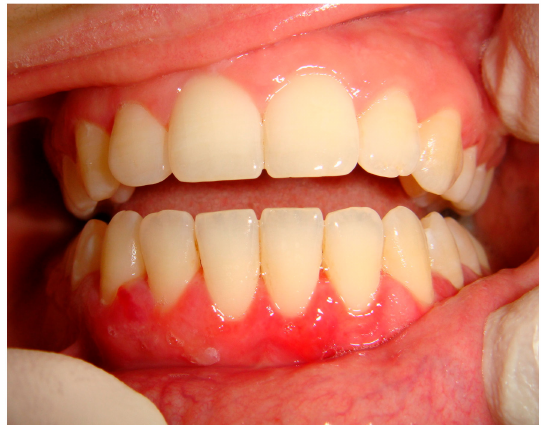
Figure 7. Diffuse desquamative gingivitis in the mandible unresponsive to the conventional medical and instrumental therapies, subsequently diagnosed as mucous membrane